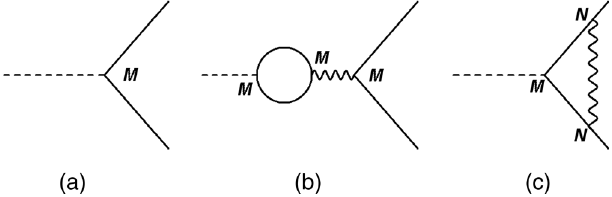
FIG. 10. (a) The bare vertex associated with a source term Ψ † M Ψ (particle-hole channel) or Ψ M Ψ (particle-particle chan- nel). M and N are four-dimensional Hermitian matrices [see Eqs. (33) and (35)]. Renormalization of the bare vertex (a) to the leading order in interaction couplings arises from diagrams (b) and (c). Note that there is no mixing of bilinear operators, since all transform differently under the symmetries; see Table II and Appendix